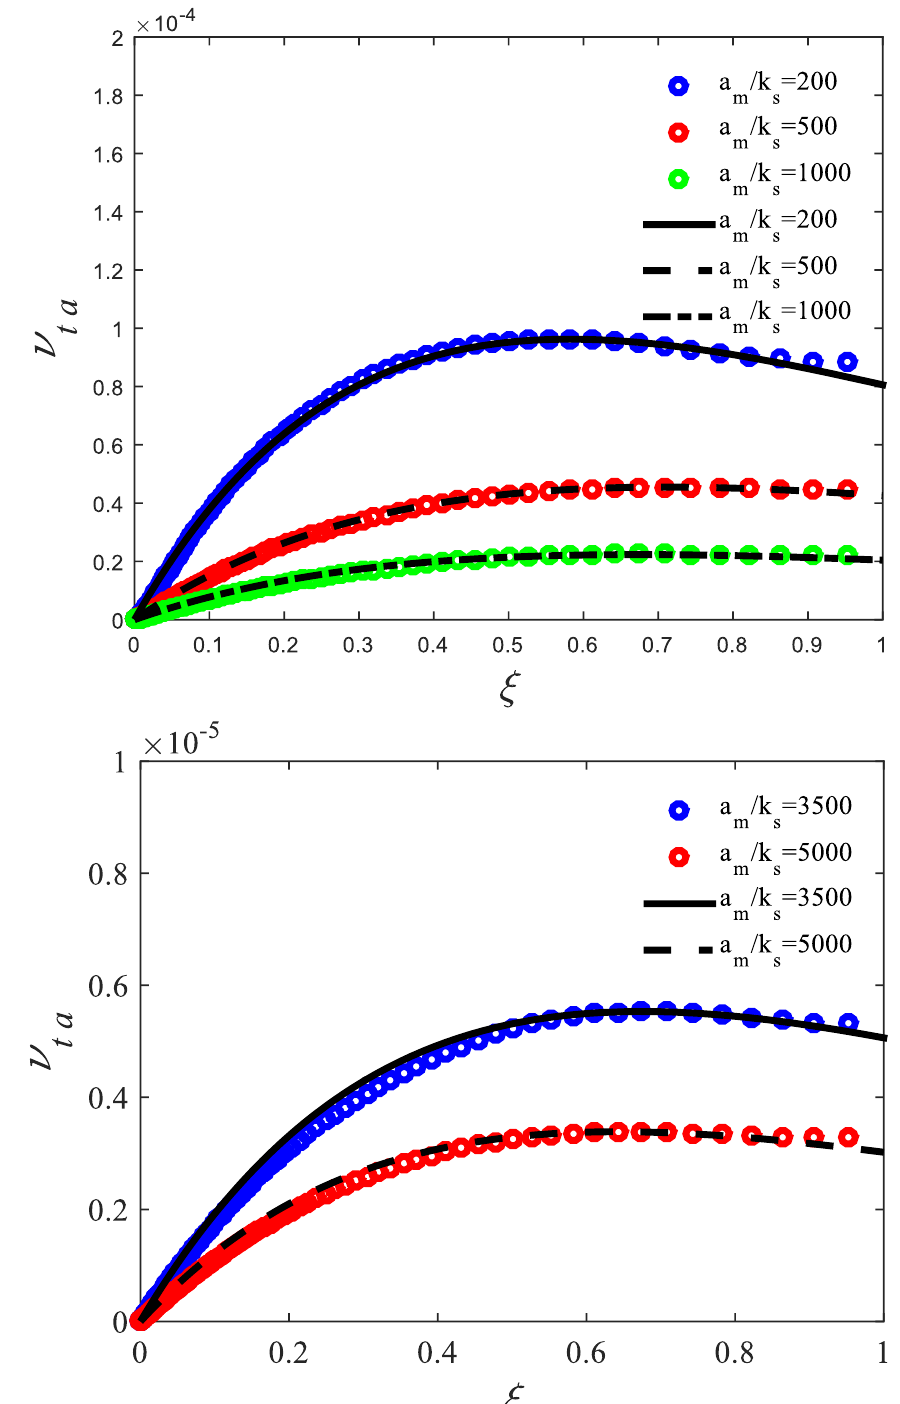
Figure 7. Period − averaged dimensionless eddy viscosity for a sinusoidal wave, curves: Equation Figure 7. Period-averaged dimensionless eddy viscosity for a sinusoidal wave, curves: Equation (4), (4), symbols: data from the BSL k- ω model, (top ) 𝑎 𝑚 /𝑘 𝑠 = 200, 500, 1000 and (bottom) 𝑎 𝑚 /𝑘 𝑠 = symbols: data from the BSL k- ω model, ( top ) a m / k s = 200, 500, 1000 and ( bottom ) a m / k s = 3500, 3500, 5000.